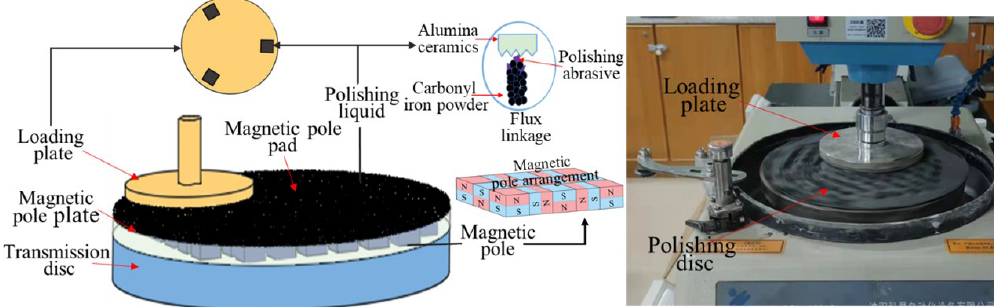
Figure 1. Principle diagram and working condition diagram of the three-point eccentric MRP device.